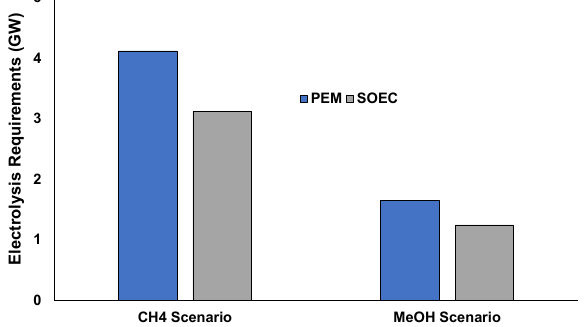
Figure 13. PEM and SOEC electrolysis requirements (MeOH: S.N. = 1.7, CH 4 : Stoichiometric).